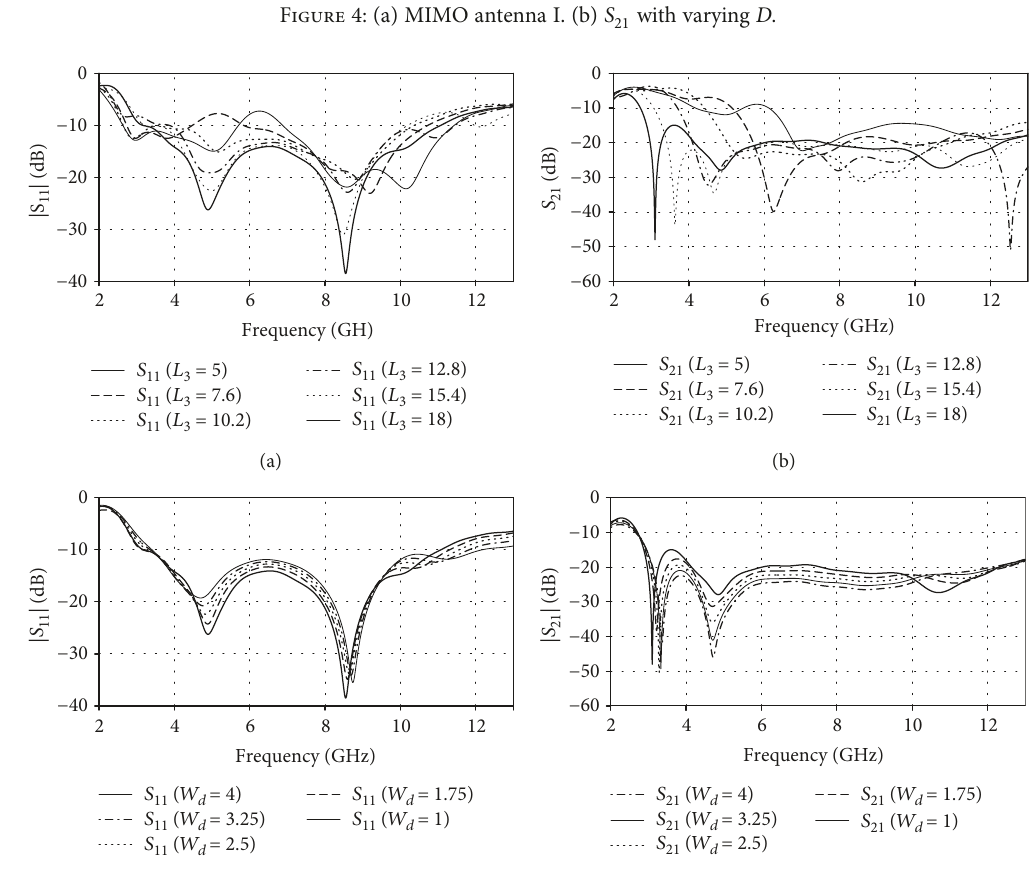
Figure 5: (a, b) | S 11 | and | S 21 | of MIMO antenna with decoupling structure with varying L 3 . (c, d) | S 11 | and | S 21 | of MIMO antenna with decoupling structure with varying W d